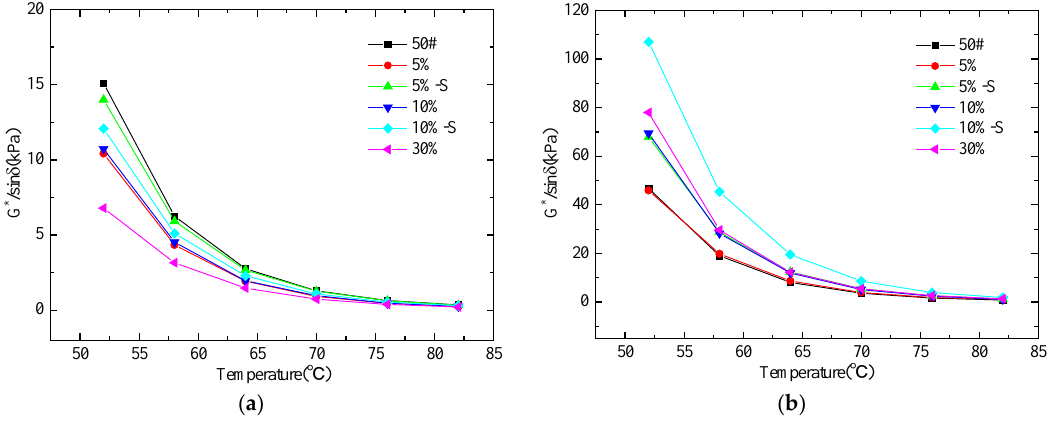
Figure 9. The relationship between rutting factors and temperature. ( a ) Unaged; ( b ) RTFO aged.